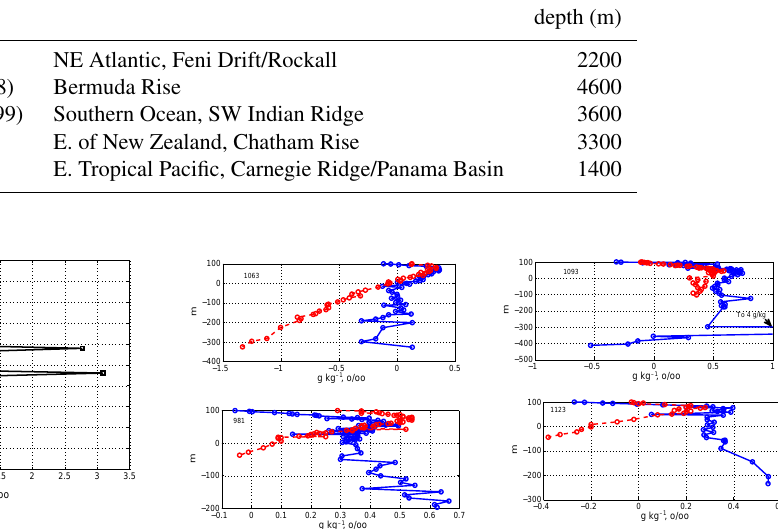
Table 2. Cores from which salinity (chlorinity) data were used, along with a reference to their initial description in the Ocean Drilling Program (ODP) and with a geographical label. A nominal water depth of the core top is also listed. Core no.